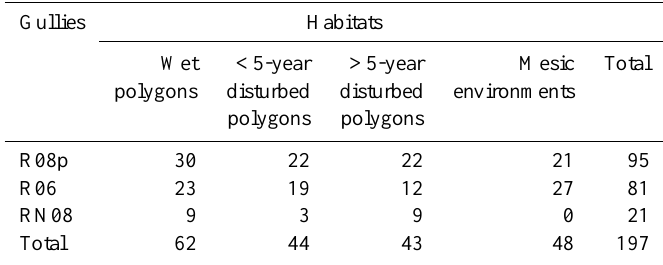
Table 1. Distribution of the sampling sites per habitat type and per